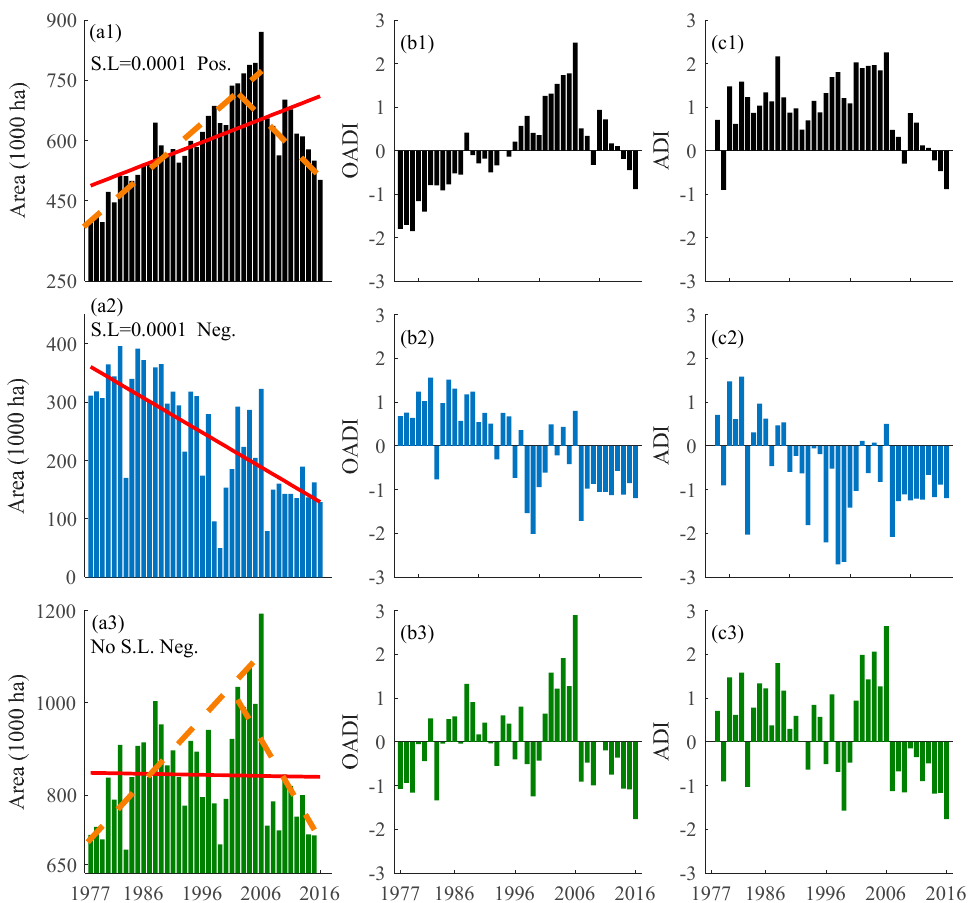
Figure 7. Change in cultivated area and agricultural drought index in Fars province (1977–2016). Diagrams 1–3 show irrigated, rainfed, and total cultivated areas; diagrams ( a – c ) show the change in area. OADI = overall agricultural drought index, ADI = agricultural drought index.